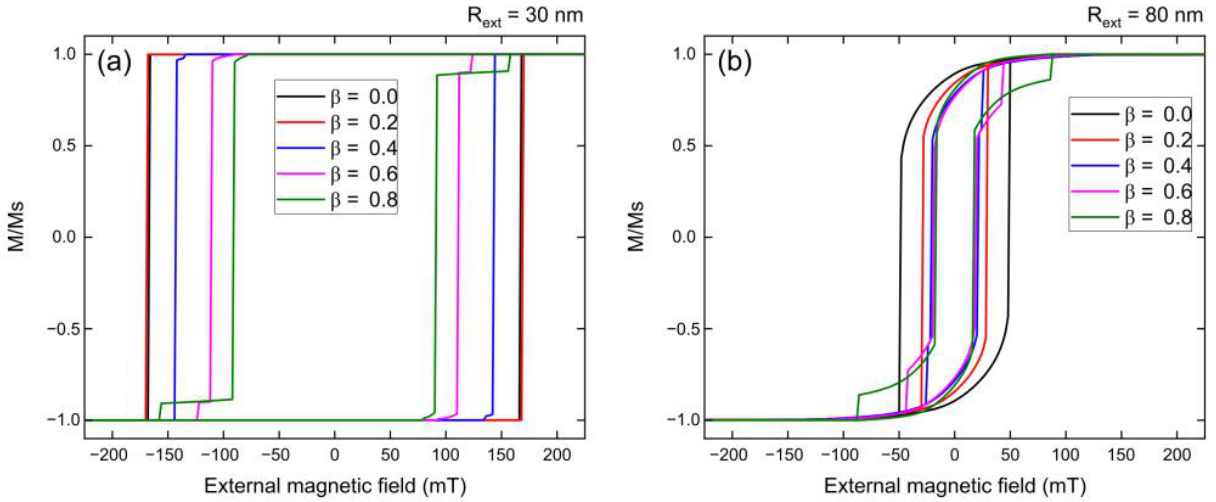
Figure 2. Hysteresis curves for 1000 nm long Fe 3 O 4 nanotubes with external radius: ( a ) R ext = 30 nm and ( b ) R ext = 80 nm, for different β values, when the external magnetic field is applied along the z - axis.